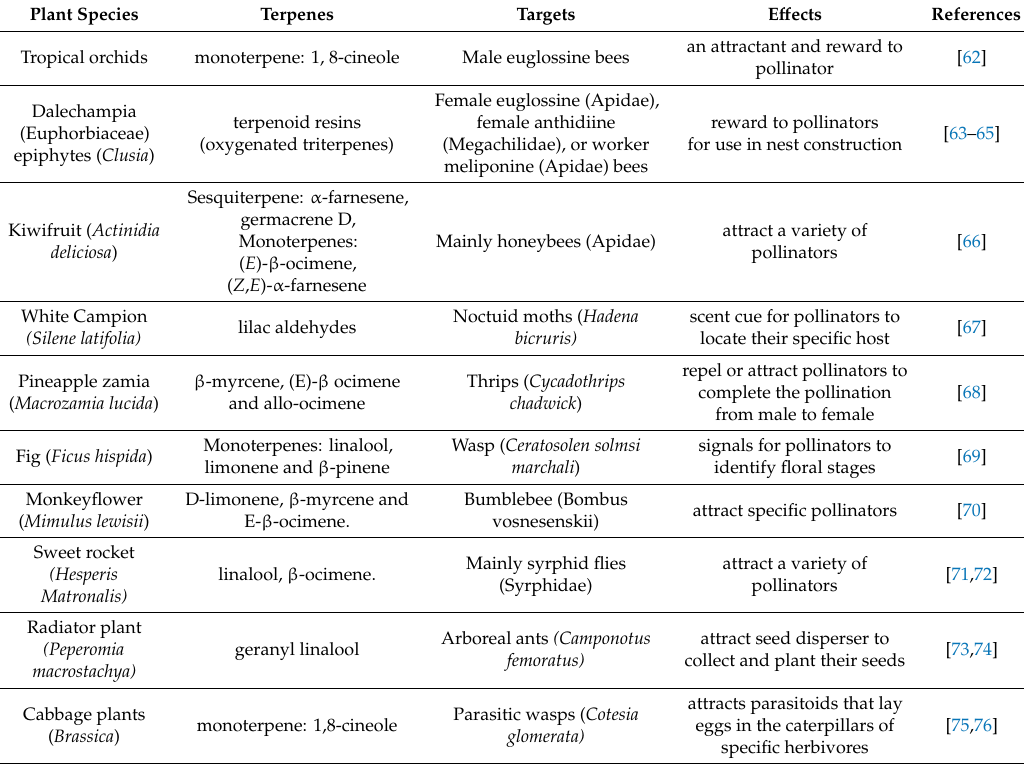
Table 2. Plant terpenes and their observed roles and e ff ects against